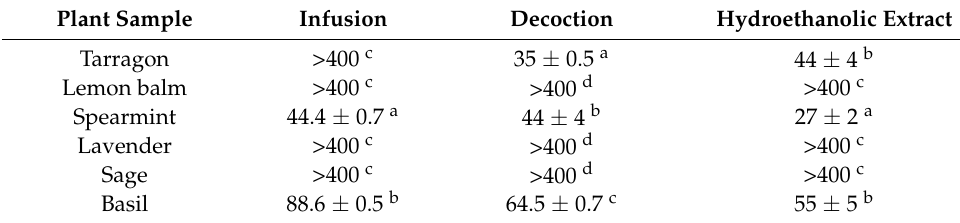
Table 2. Anti-inflammatory activity of the plant extracts (IC 50 values; µ g/mL). Plant